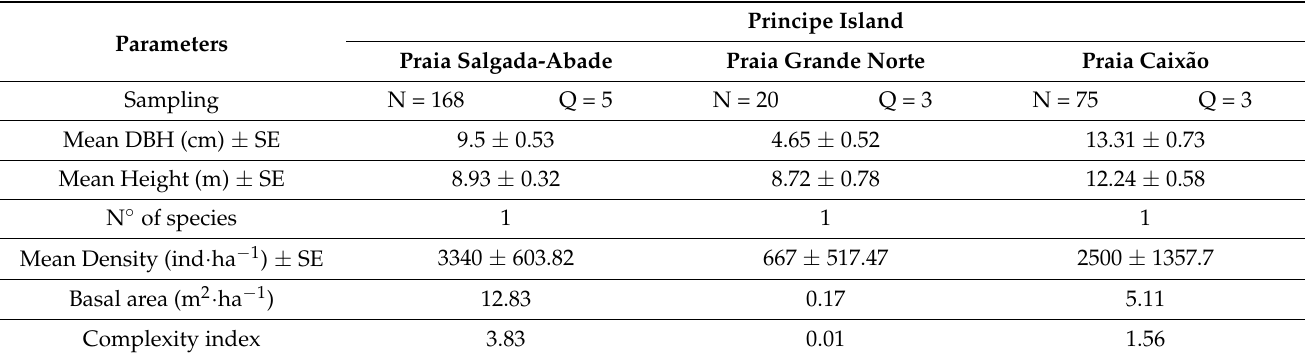
Table 4. Mangrove structural parameters at the different locations on Pr í ncipe